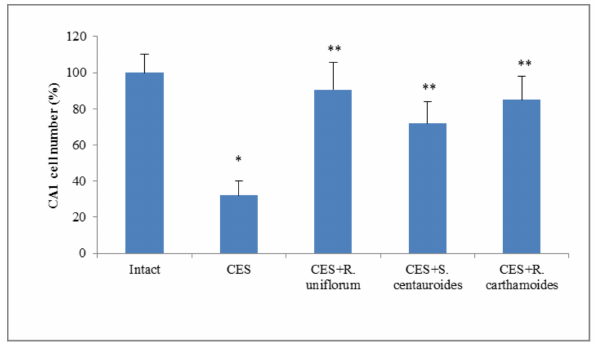
Figure 6. The effect of R. uniflorum and S. centauroides extracts on the number of viable neurons in the dorsal hippocampus (CA1) in the rats exposed to chronic emotional stress (CES). Data represent as mean ± S.E.M.*— p < 0.05 vs. intact group; **— p < 0.05 vs. CES group.